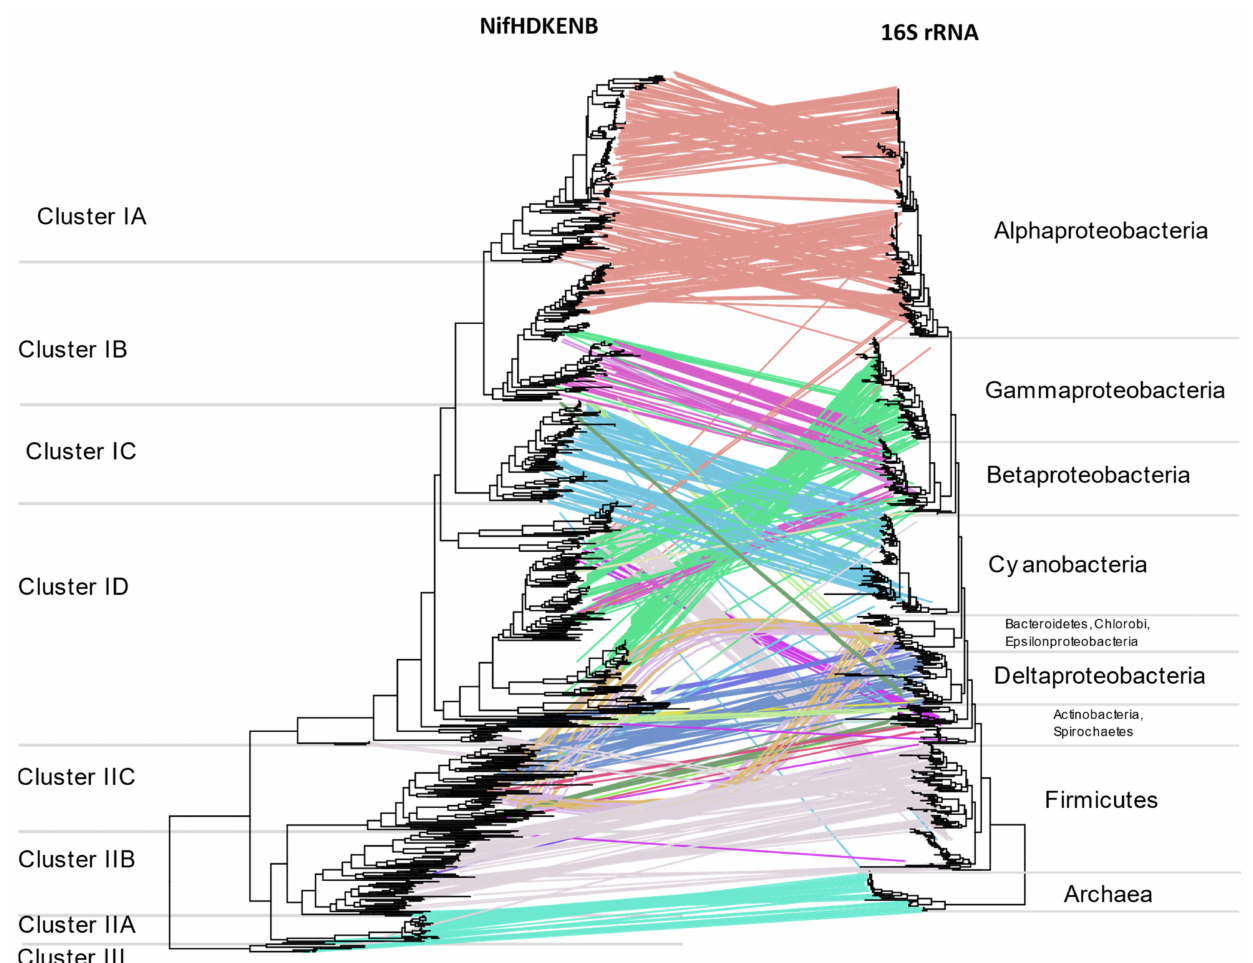
Figure 9. Tanglegram comparing the concatenated NifHDKENB tree with 16S rRNA phylogeny of the diazotrophs, both obtained using FastTree. Lines indicate the respective positions of the 963 bacteria in the 2 trees. See Supplementary Tree File for details of the horizontal gene